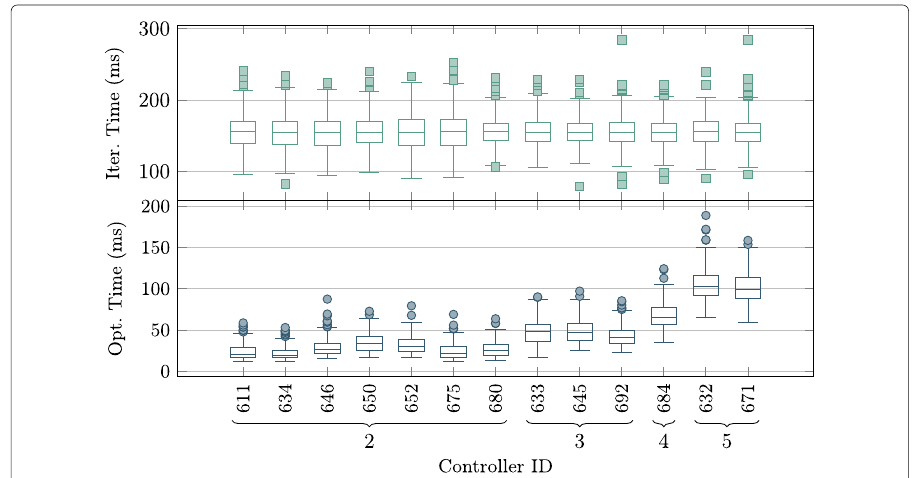
Fig. 7 The two plots show statistics for the time needed for optimization and the time needed for all the steps done in each iteration for all controllers of the IEEE 13 node test